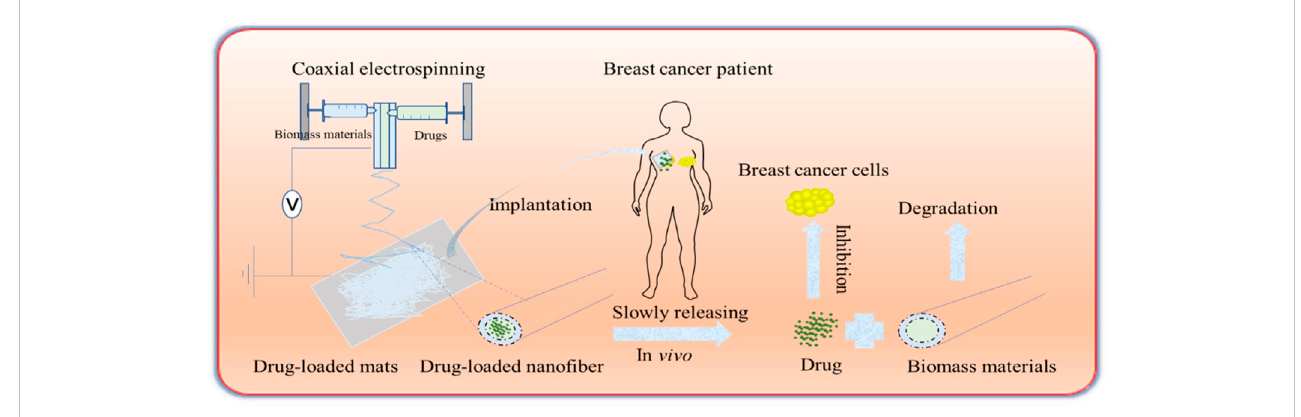
FIGURE 2 Schema of biomass-derived fi bers for drug delivery. The drugs and biomass materials are made into porous nano fi ber mats by coaxial electrospinning. The mats are transferred into the tumor areas of patients with breast cancer, etc. The drugs are released gradually, and the drugs inhibit tumor growth, while the biomass materials can be degraded